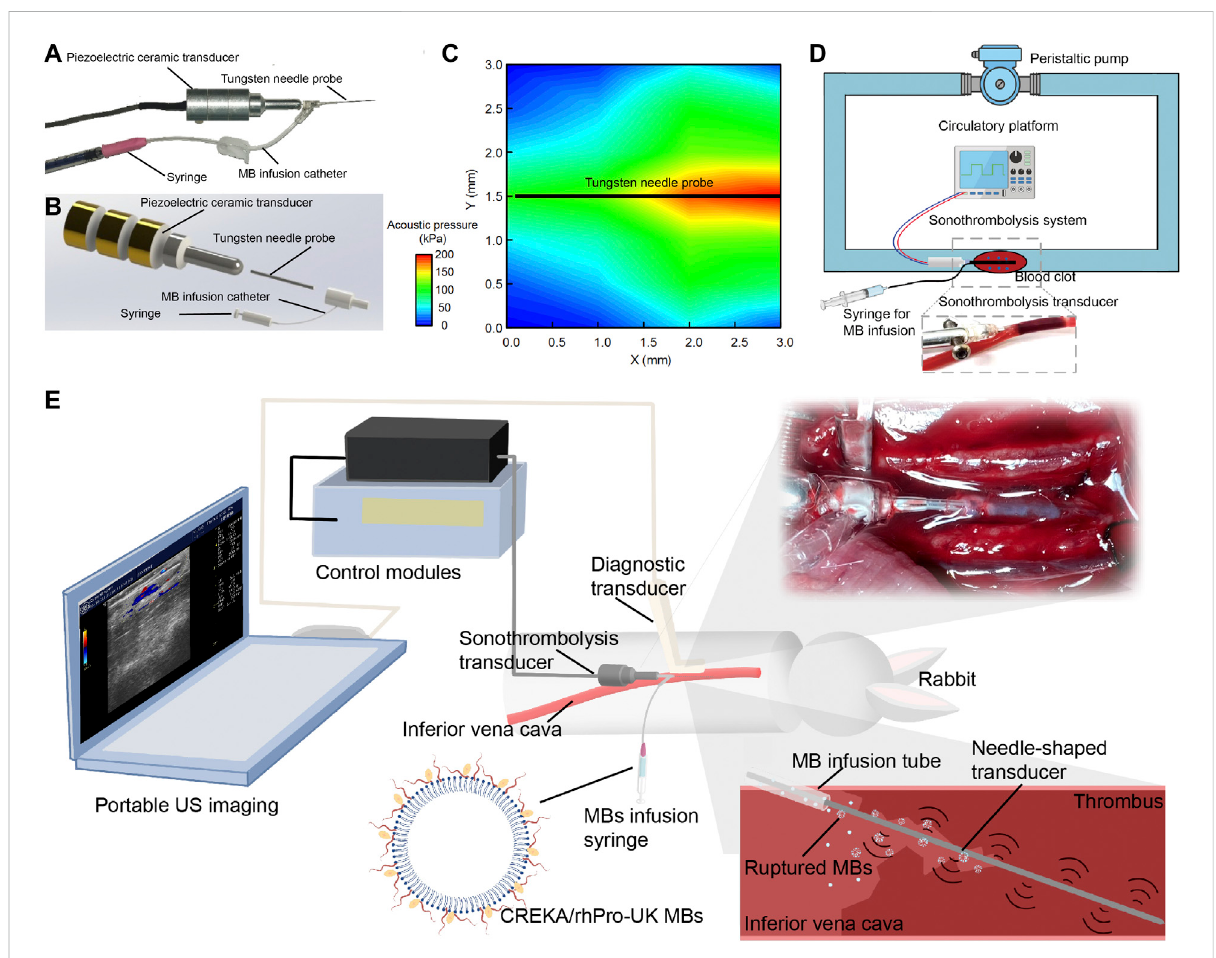
Endovascular microbubble-enhanced LFUS sonothrombolysis system and the experimental platform. (A) Physical display and (B) schematic display of the endovascular microbubble-enhanced sonothrombolysis system. The tungsten needle probe is connected to piezoelectric ceramic transducer. The intra-clot delivery of LFUS is realized through the insertion of needle probe into the blood clot. At the end of the needle probe is a catheter for MB delivery. (C) The spatial distribution of acoustic pressure adjacent to the tungsten needle probe. (D) Schematic display of the fl ow model in vitro . A magni fi ed image of the needle probe inserting into the tube and blood clot is presented. (E) Schematic display of rabbit IVC thrombosis model and microbubble-enhanced sonothrombolysis systems with a portable US imaging device for intraoperative ultrasonic evaluation. A magni fi ed image and a schematic display of the needle probe inserting into the IVC thrombosed segament is